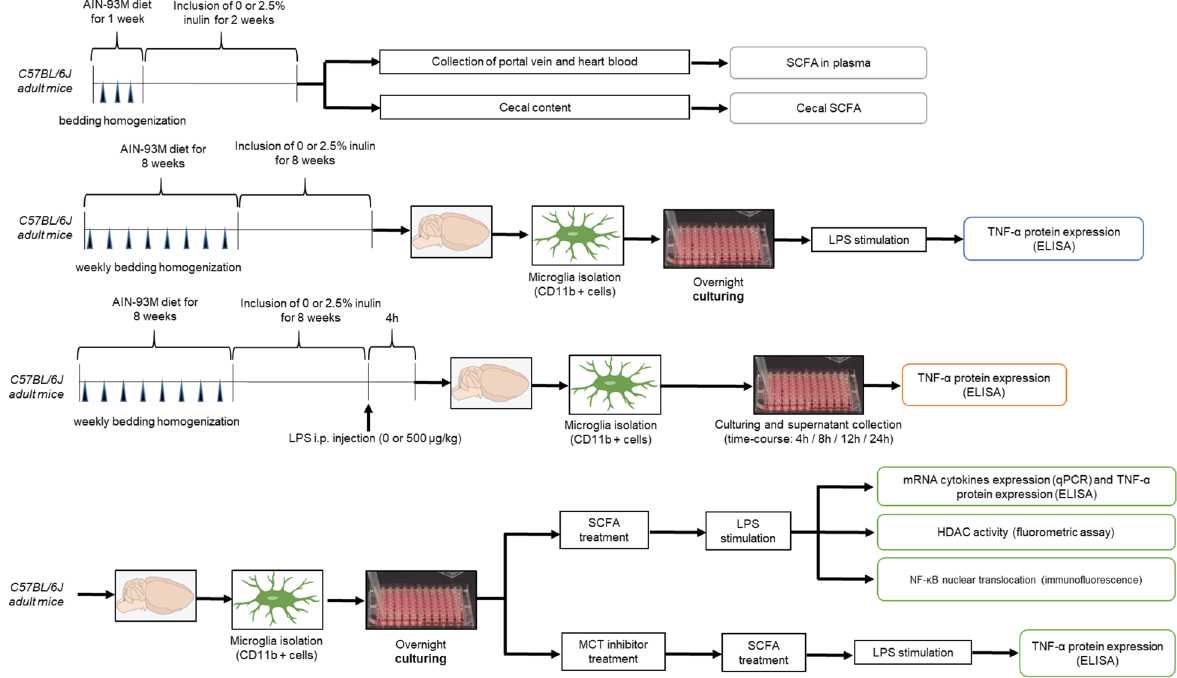
Figure 8. Experimental design. Specific conditions such as time and concentrations are described in the Methods section and in the respective Figure